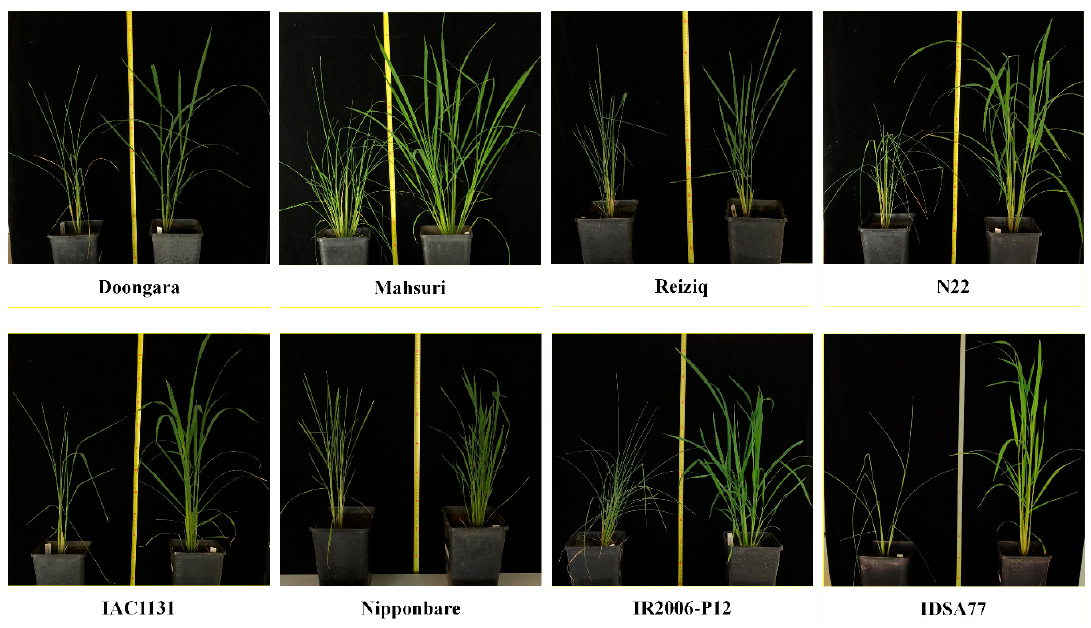
Figure 6. Rice genotypes used in the study under control (right) and drought stress (left) conditions. The leaves in stress conditions were rolled due to the severe drought stress.